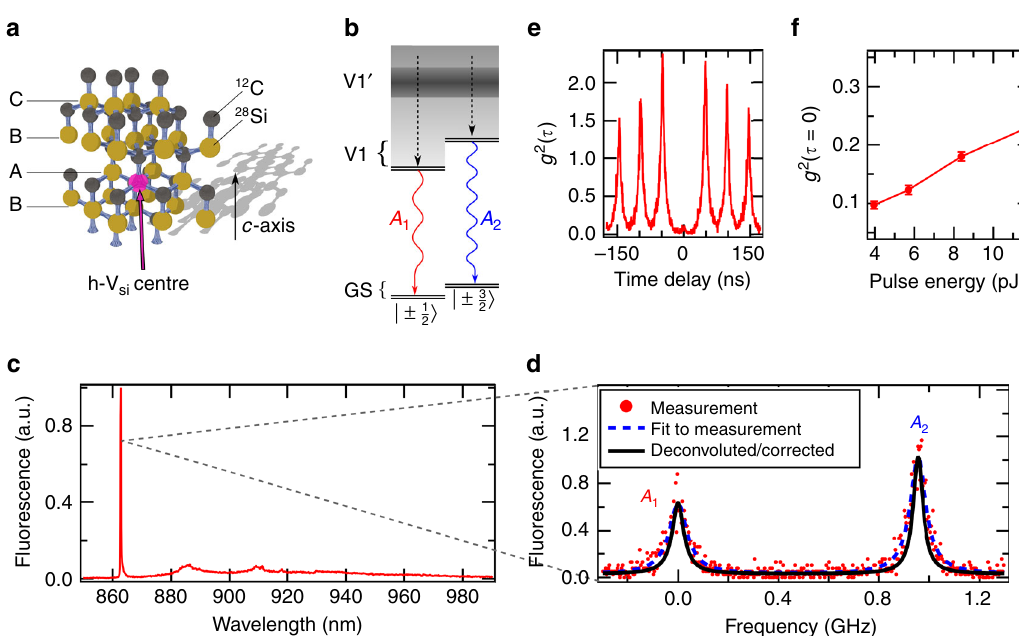
Fig. 1 Optical properties of single silicon vacancies h-V Si . a Crystallographic structure of 4H-SiC and position of h-V Si centre (highlighted by a pink sphere symbolising a missing Si atom). b Level structure of the h-V Si centre at zero magnetic fi eld. Ground state (GS) and V1 excited state show degenerate sublevels ¼ ± 1 ¼ ± 3 m and m . Optical transitions between V1 and GS are spin conserving and associated with the transitions A 1 and A 2 . Emission from the second S S 2 2 excited state, V1 ’ , is not observed owing to ultrafast relaxation (dashed arrows). c Single h-V Si centre emission spectrum under off-resonant excitation. d ZPL emission fi ne structure recorded over 20min. The red dots are raw data. The two emission lines associated with A 1 and A 2 transitions are clearly resolved. The blue dashed line is a Lorentzian fi t to the raw data, giving linewidths (FWHM) of 86±6 and 77±6MHz for the A 1 and A 2 lines, respectively. The black line is data after deconvolution correction for the fi nite linewidth of the scanning Fabry – Pérot cavity (Lorentzian FWHM of 29±2MHz), the resulting real emission linewidths are 57±6 and 48±6MHz, respectively, which is very close to the Fourier transform limit. e Second-order autocorrelation function recorded for a single h-V Si centre under pulsed off-resonant excitation (pulse energy: 5.7pJ). We observe g 2 ( τ = 0) = 0.12±0.01, clearly indicating single-photon emission. f g 2 ( τ = 0) as a function of laser pulse energy. The line is a guide to the eye. Error bars correspond to one standard